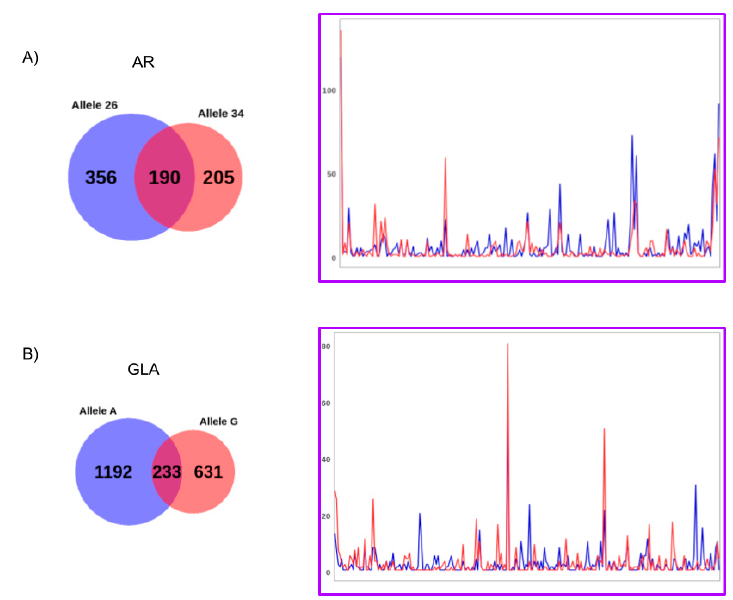
Figure 6. Results of the epialleles analysis for the AR ( A ) and GLA ( B ) allelic sequences from subject 1. The Venn diagrams summarize the number of allele-specific (red and blue circles) and shared (purple circle) epialleles. For the shared epialleles (excluding the fully unmethylated epiallele), the allelic counts are shown (red and blue lines). The epialleles are ordered on the x -axis based on the increased number of methylated sites.